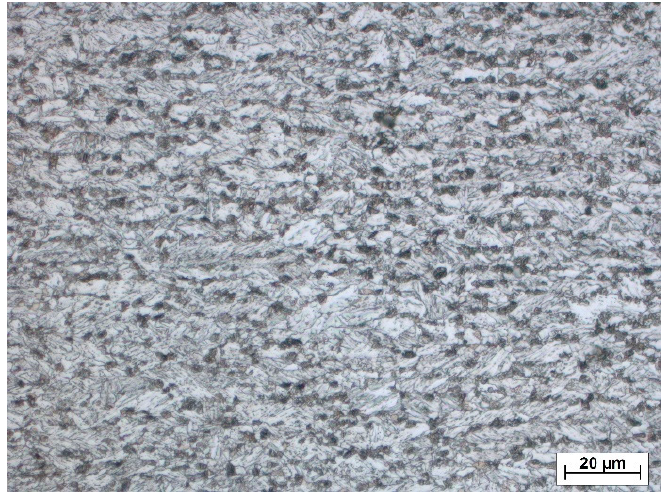
Figure 8. Microstructure of the inter-critical heat-affected zone (ICHAZ).